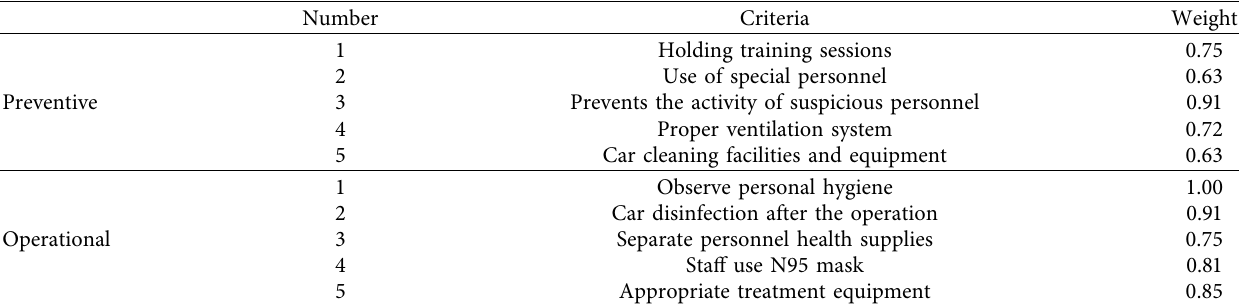
Table 3: Weighting of criteria by the triangular fuzzy aggregation